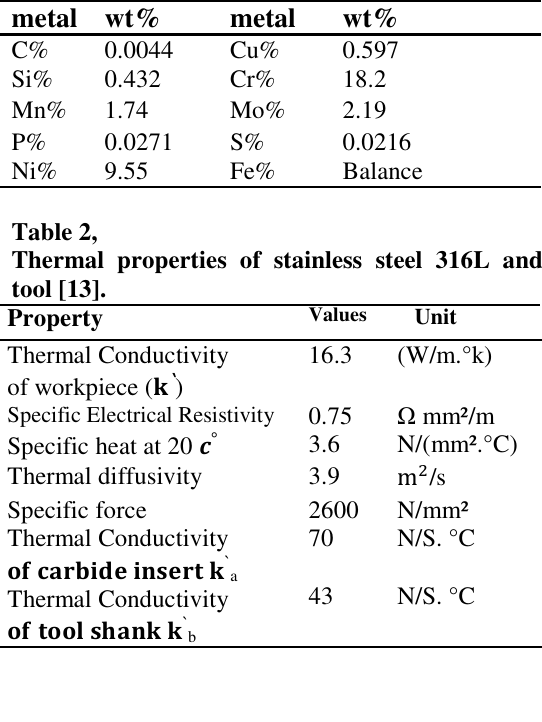
Chemical composition of stainless steel 316L.